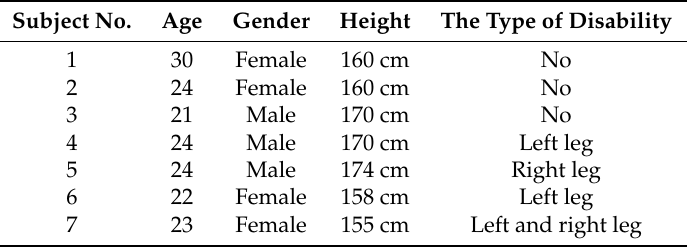
Figure 12. A user in a lower limb holder. Table 4. The subjects in the offline data collection